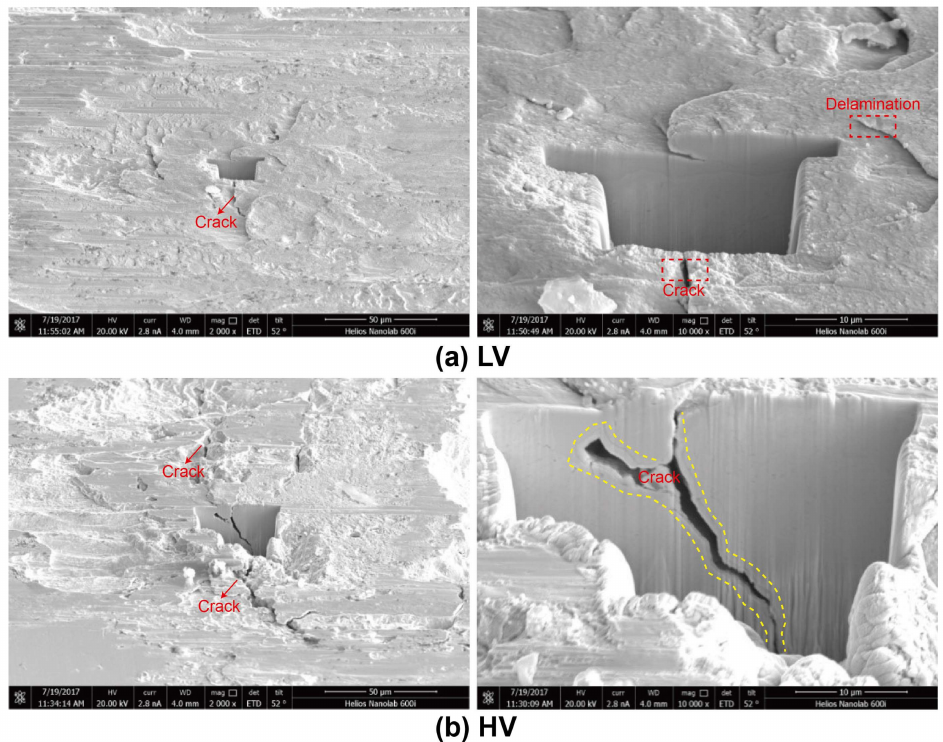
Figure 10. Cross-section images of the worn surface under different vacuum conditions. ( a ) LV; ( b ) HV.